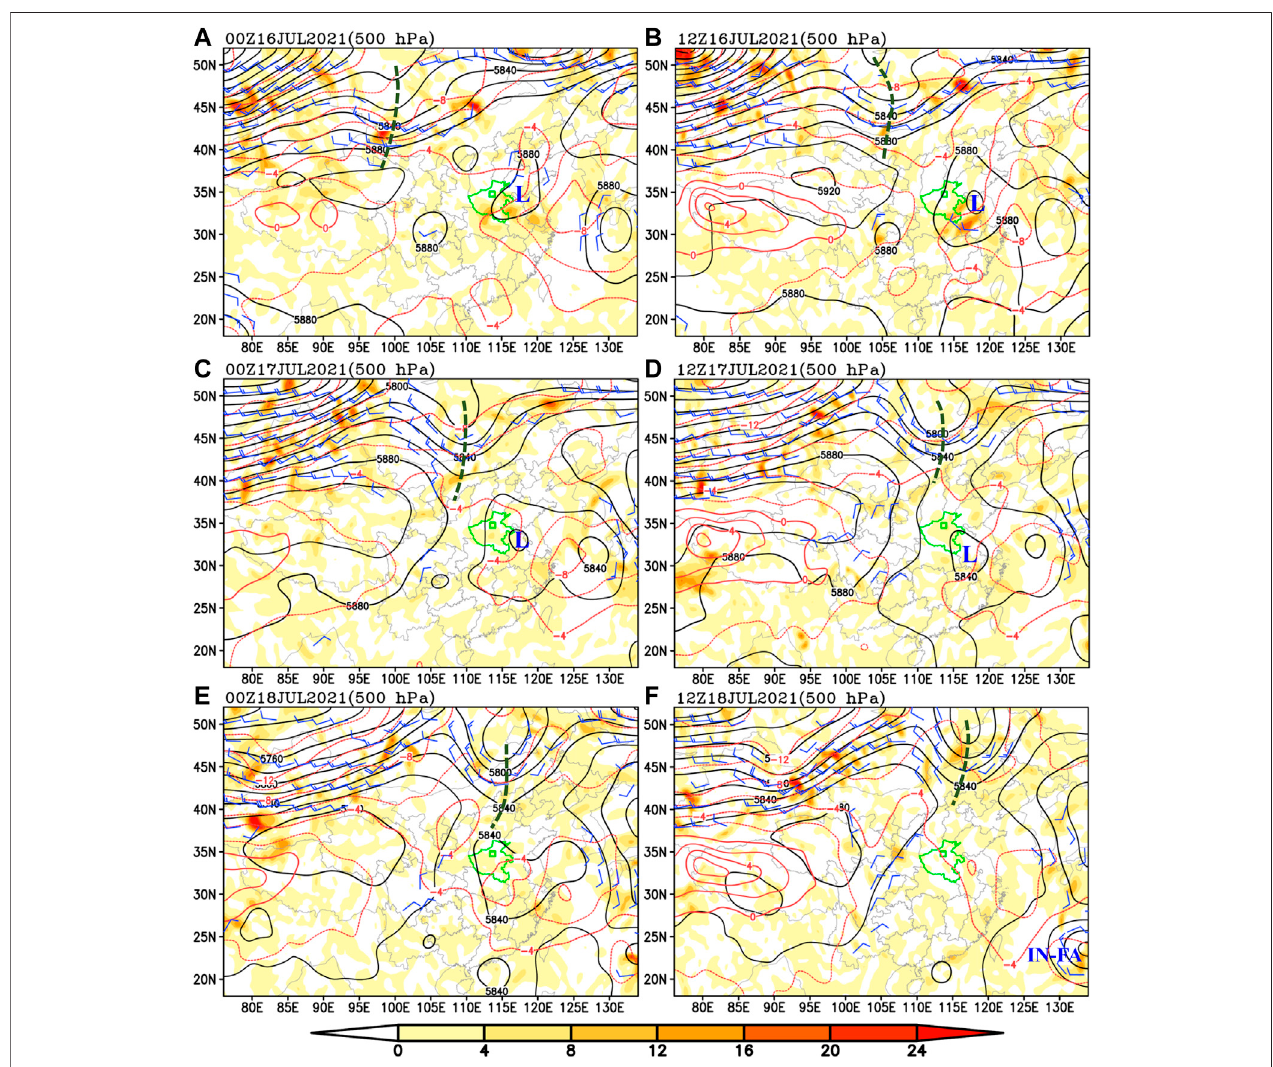
FIGURE 3 | Temperature advection (shading, units: 10 − 5 K s − 1 ), geopotential height (black solid lines, units: gpm), temperature (red lines, units: ° C), and strong winds(above10 m s − 1 ;afullbarrepresents10 m s − 1 )at500 hPa,wherethesmallpurpleboxmarksthelocationofZhengzhou, “ L ” meanslow-pressurecenter,andthe thick dashed line represents the trough